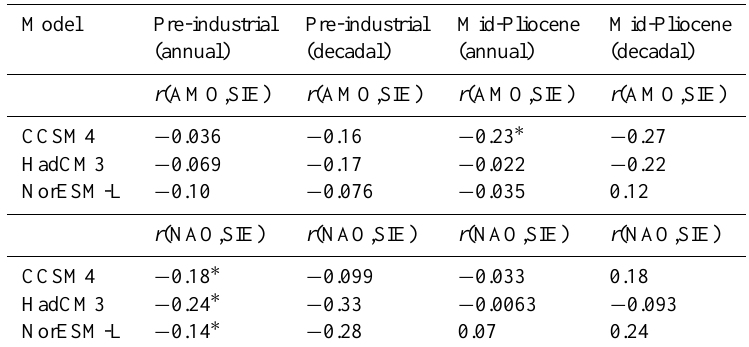
Figure 13. Mean annual ocean surface currents and sea ice thicknesses (m) for HadCM3 pre-industrial (left) and mid-Pliocene (right) simulations. Vector length is proportional to ocean current speed. Table 3. Correlation between AMO and NAO indices, and mean annual and decadal Arctic sea ice extent (SIE) for three PlioMIP models. Starred values are significant at the 90%